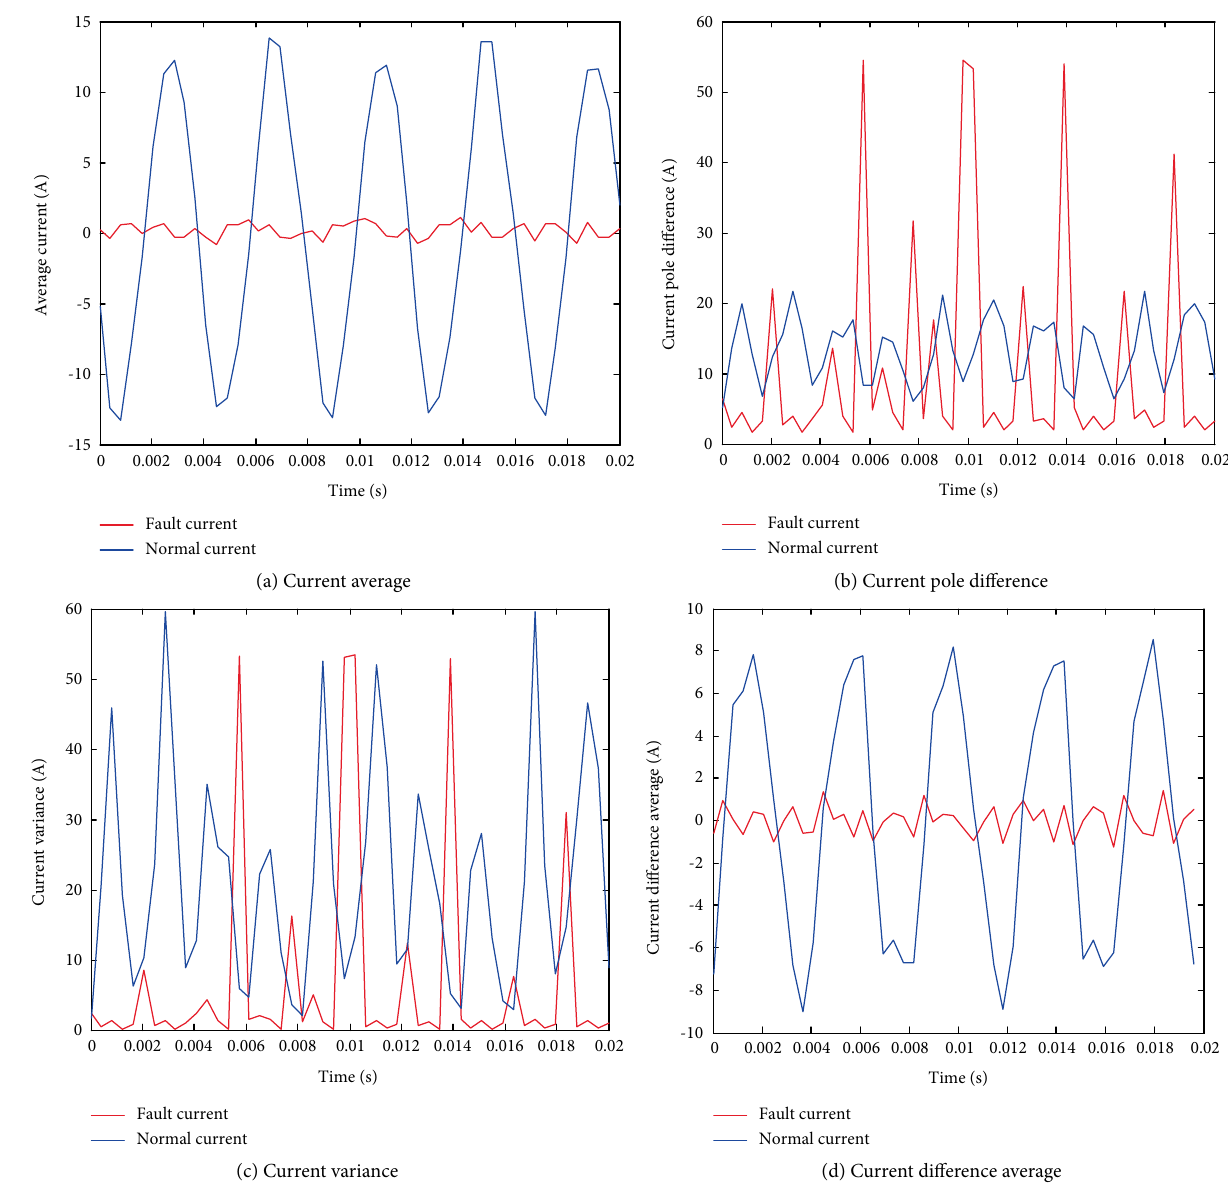
Figure 2: The time domain features extraction of induction cooker load